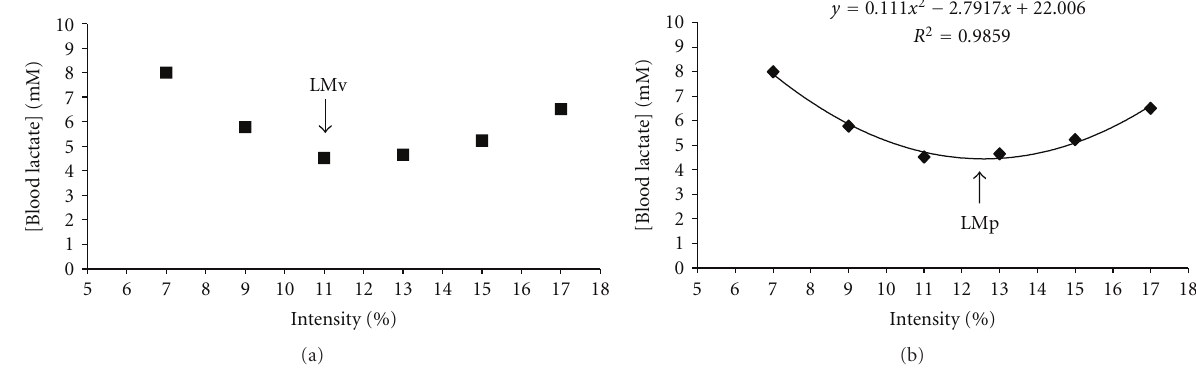
Figure 1: Determination of lactate minimum intensity during LM test using visual inspection (LMv) (a) and polynomial function (LMp) (b).